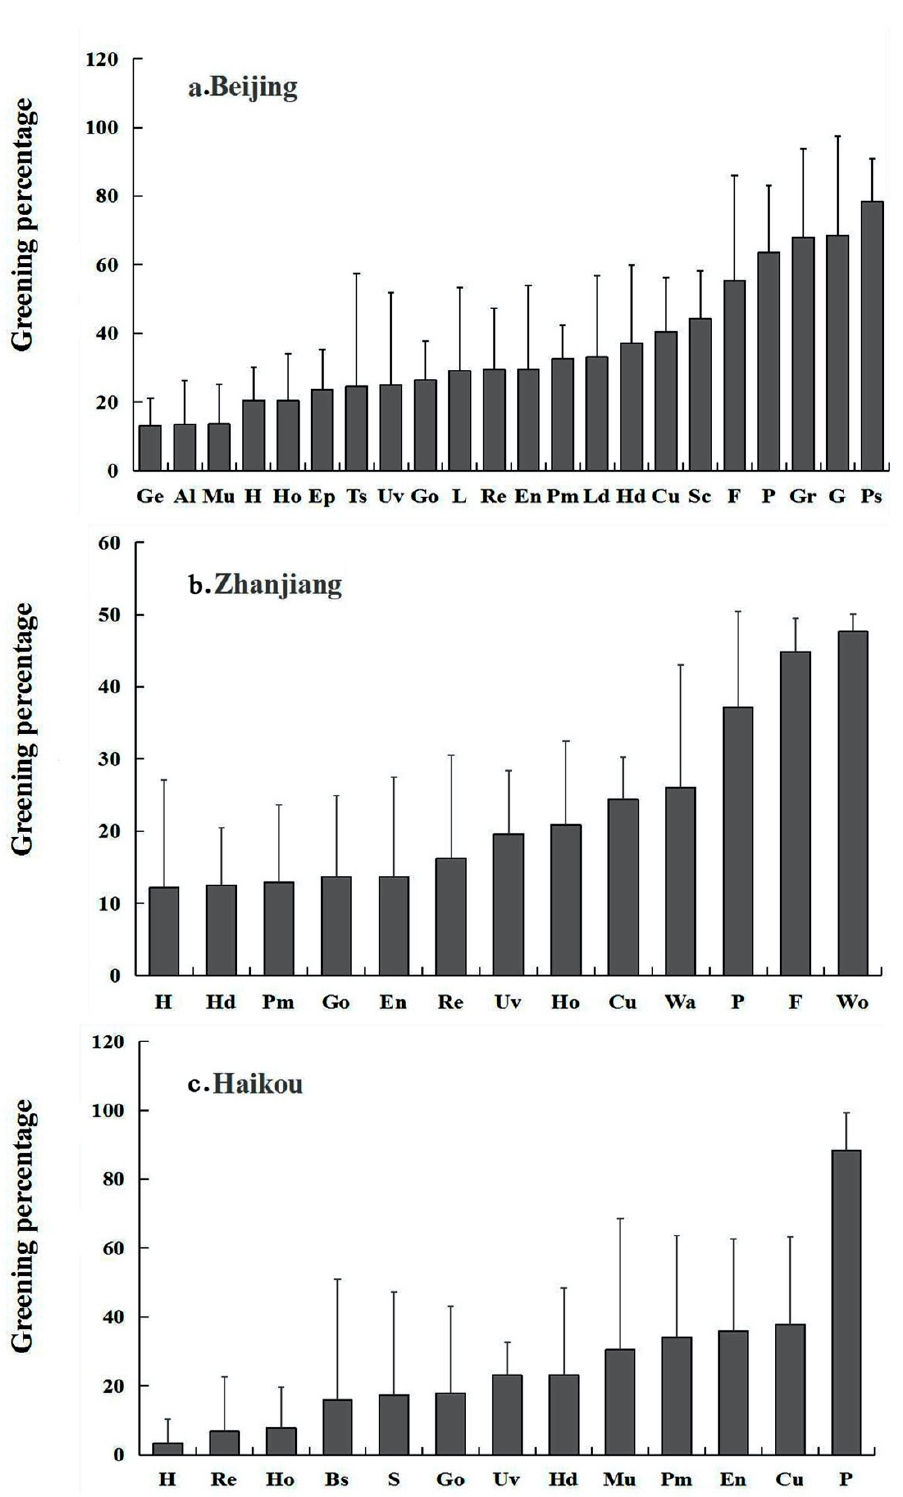
Figure 4. GreeningpercentagesofdifferentsecondaryurbanfunctionalunitswithinBeijing( a ),Zhanjiang( b ), and Haikou ( c Figure 4. Greening percentages of different secondary urban functional units within Beijing ( a ), Zhanjiang ( b ), and Haikou ( c ).